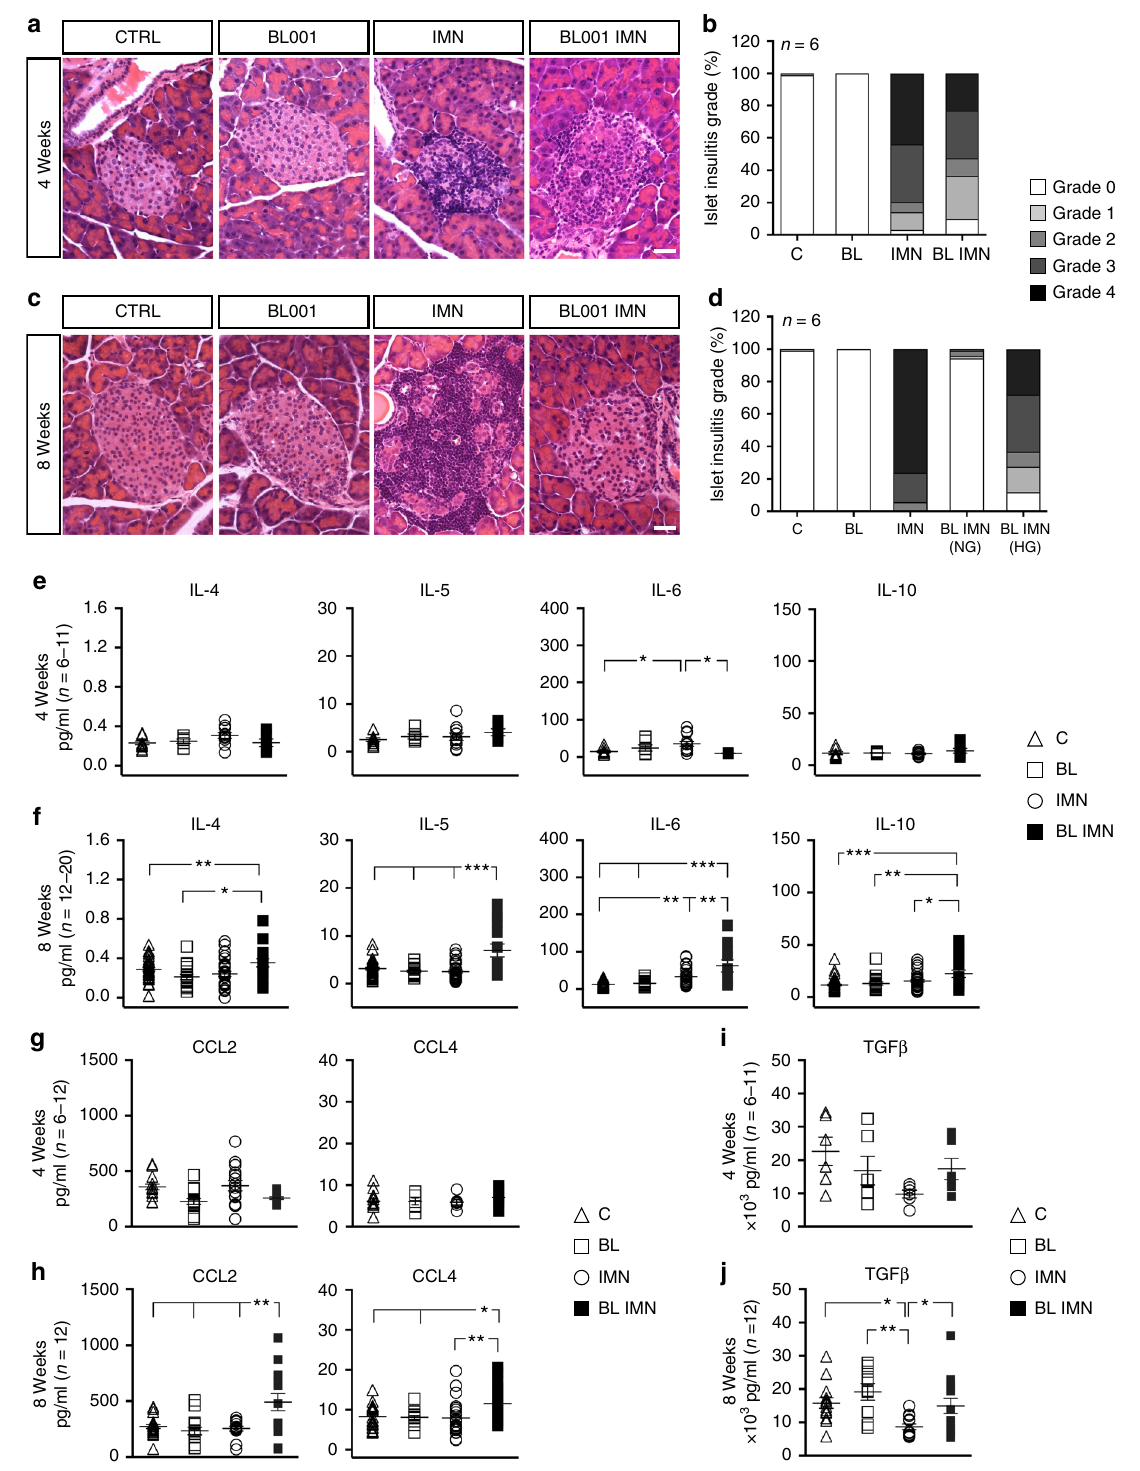
Fig. 2 BL001 decreases insulitis and modulates the blood cytokine pro fi le. Histology (representative images, scale bar: 25 µ M) and morphometry at a , b 4 and c , d 8 weeks revealed that treatment with 10 mg/kg b.w. BL001 decreased the incidence and severity of insulitis in immunized RIP-B7.1 mice. At 8 weeks, BL001-treated and immunized mice that developed hypeglycemia exhibited a similar degree of insulitis to the BL001-treated and immunized mice that were normoglycemic at 4 weeks. Impact of BL001 treatment on the pro fi le of cytokines, chemokines and TGFbeta at 4 weeks ( e , g , i ) and 8 weeks ( f , h , j ). Plots show individual mice values. * p < 0.05, ** p < 0.01, and *** p < 0.001, one-way